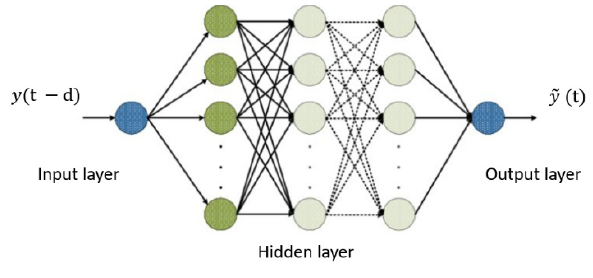
Figure 3. The structure consists of an input [y(t-d)], output , and hidden layer nodes and the connecting lines. Here d represents past values of time series used to predict the wind speed ahead of time. The input node is also the feedback node. In developing the NARNN and NARNNX* models, the predicted time series is the wind speed and the external time series included in the input, x(t) is the exogenous input. The exogenous inputs used in the present work are ambient temperature and pressure.